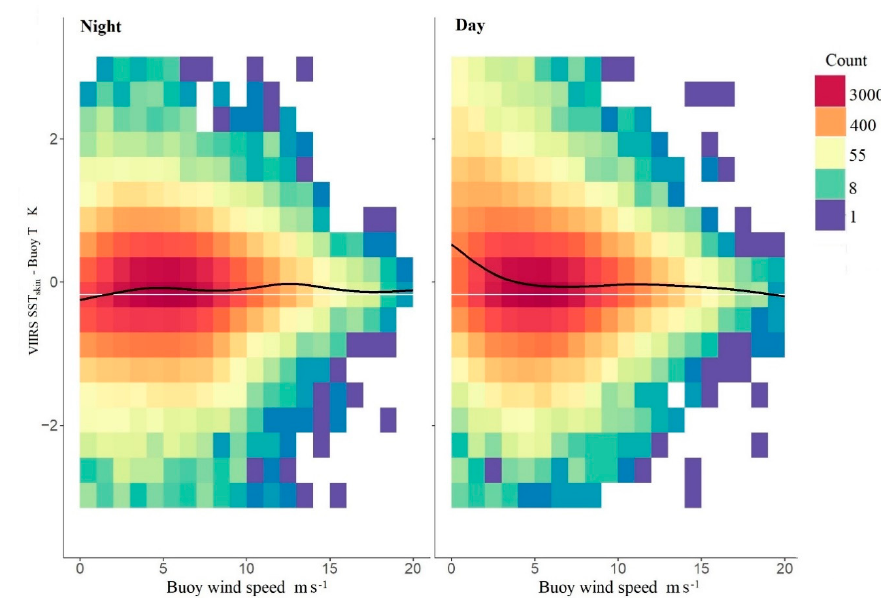
Figure 13. Wind speed dependence of the difference between VIIRS SST skin and subsurface temperature from drifting buoys, nighttime conditions at left and daytime at right. The increase in the differences at low wind speeds during the day indicate the effects of diurnal heating. The colors represent the number of matchups in each cell. The black line is a spline fit to the data and the white line is the mean skin e ff ect of − 0.17 K.